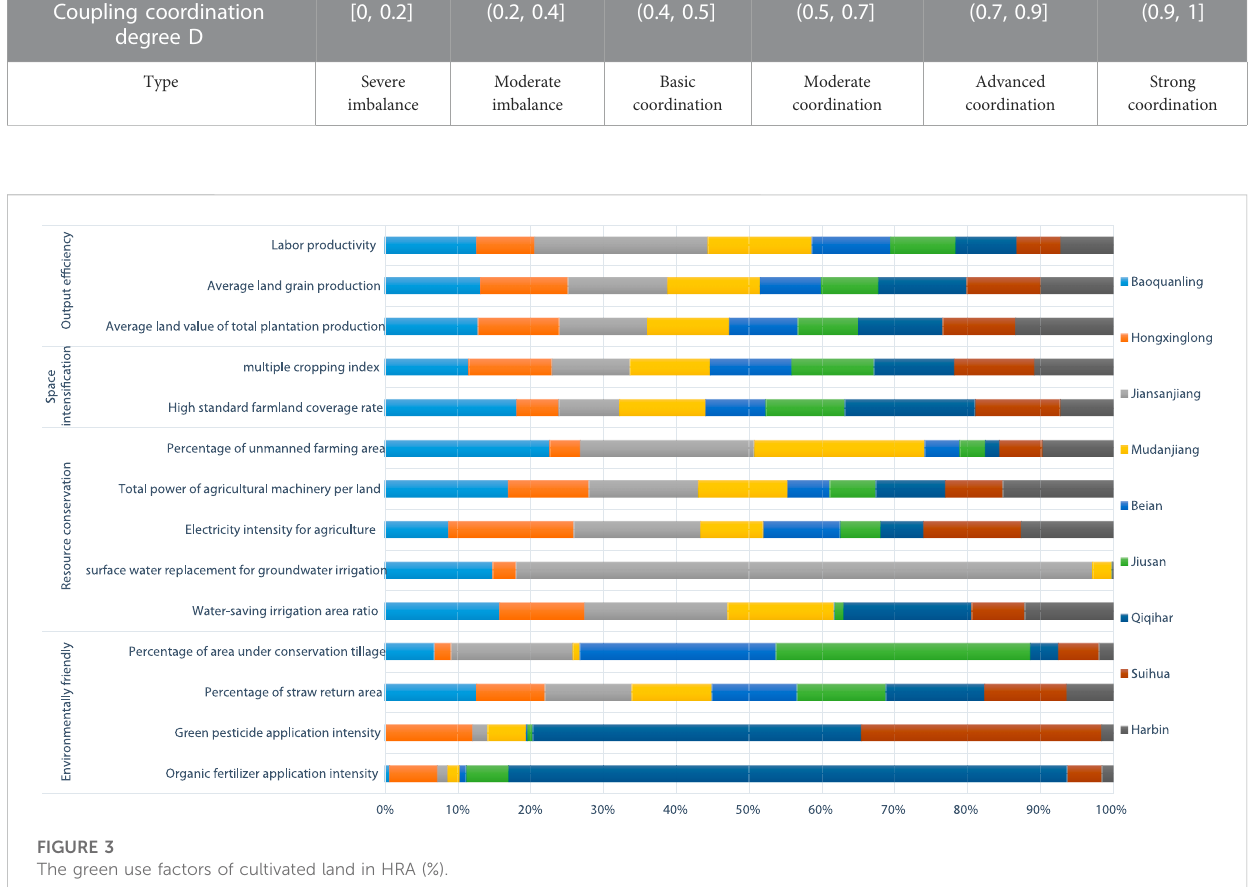
FIGURE 3 The green use factors of cultivated land in HRA